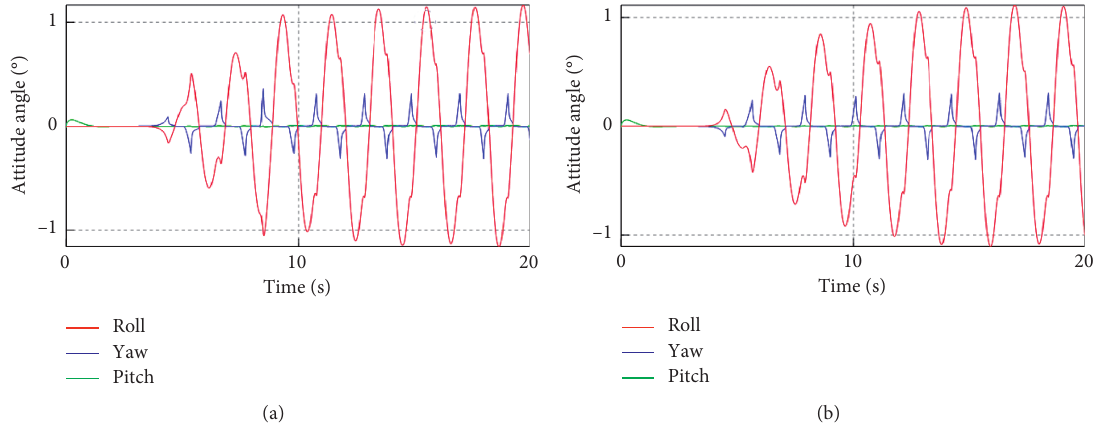
Figure 17: Changes of the attitude angle under different guide wheel treads: (a) 340mm and (b) 540